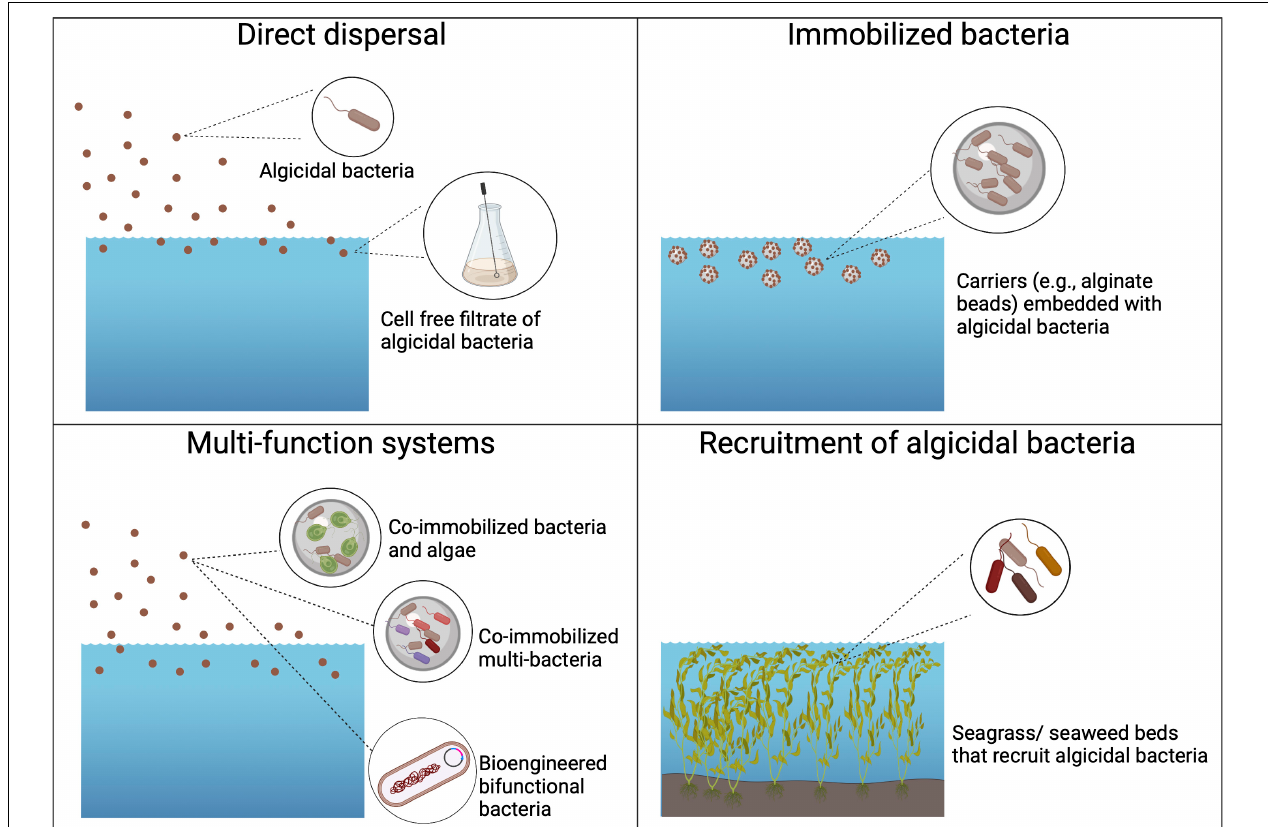
FIGURE 5 | Potential application strategies of algicidal bacteria for HAB prevention and mitigation. Current and proposed strategies include direct dispersal of algicidal bacteria and/or their algicides, application of immobilized algicidal bacteria, deployment of multi-function systems, and restoring seagrass/seaweed beds to recruit algicidal bacteria. See texts for details. Created with